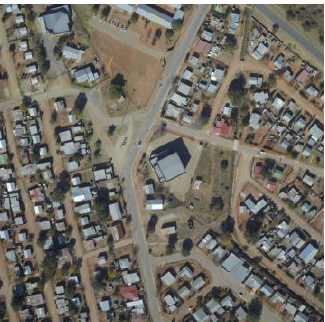
Figure 11. The optimized extraction of line features on the remote sensing